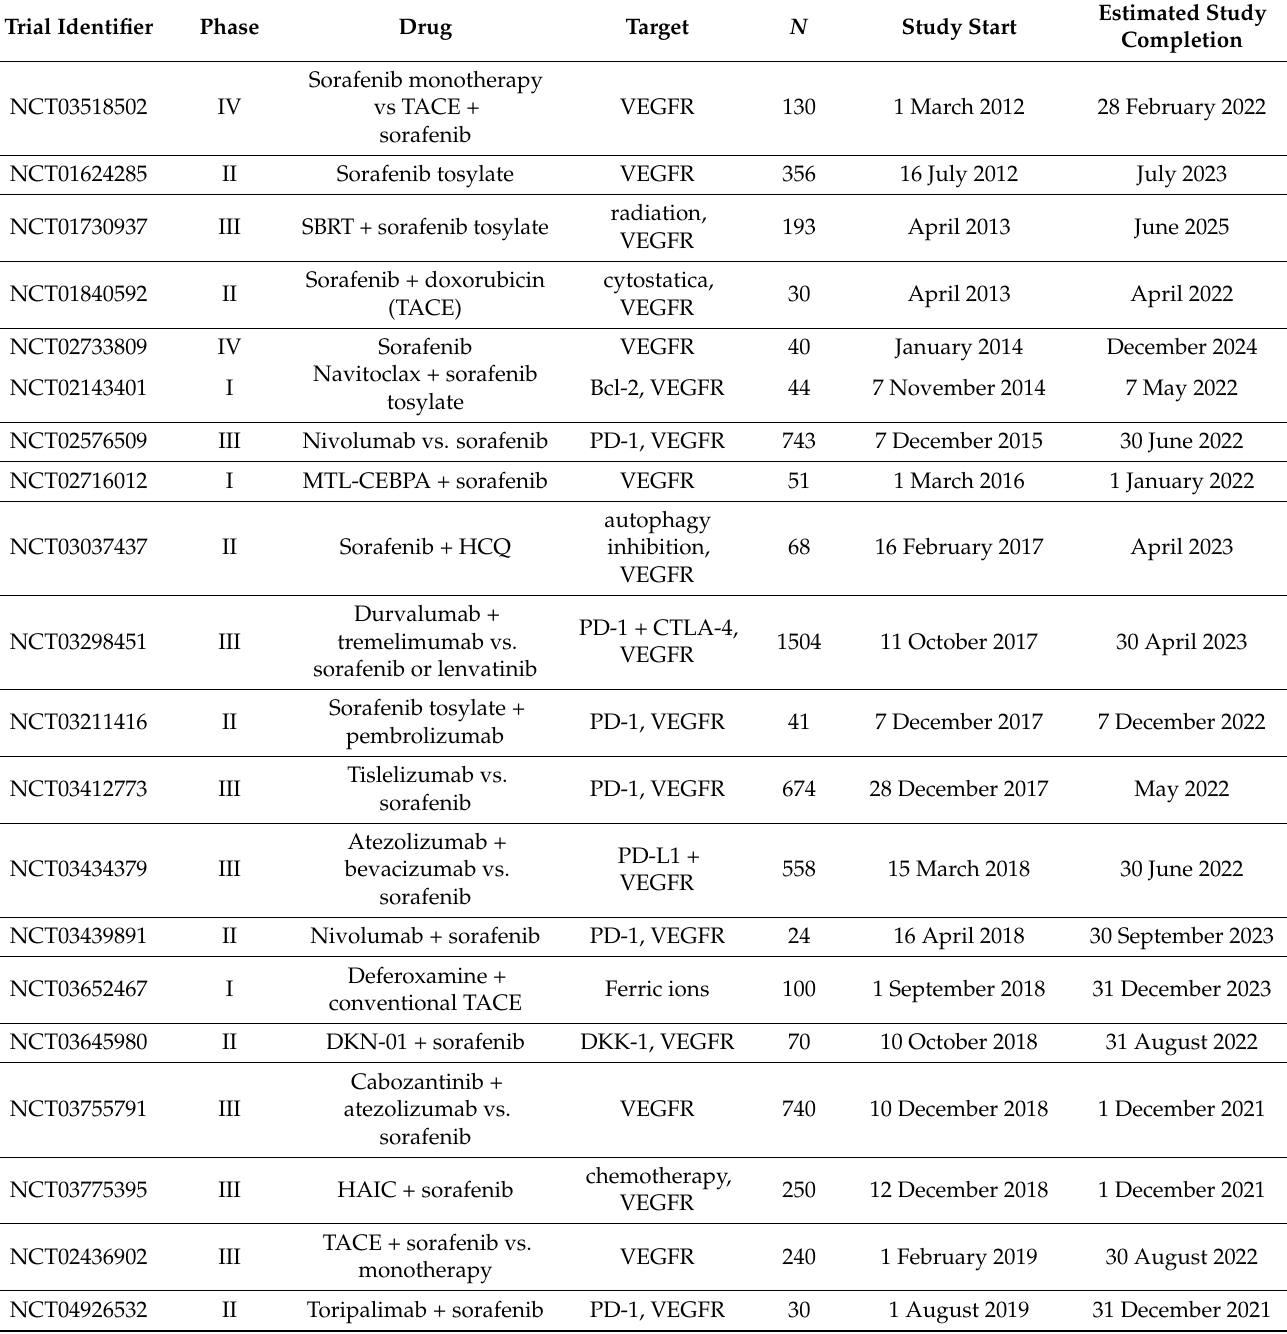
Table 2. Ongoing clinical trials with ferroptosis-associated agents for HCC treatment. clinical studies are needed to determine the therapeutic value of ferroptosis induction in patients with HCC as preclinical data are not